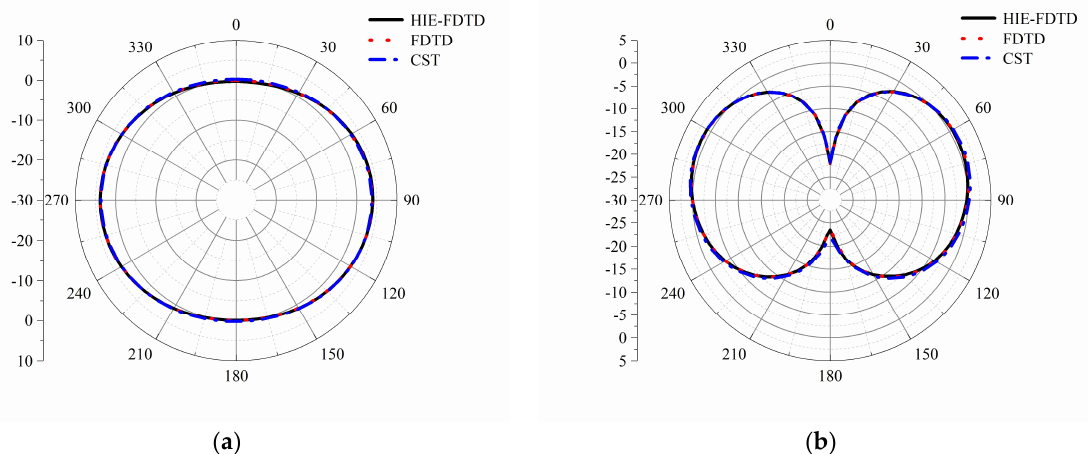
Figure 5. Directivity patterns of the planar monopole antenna: ( a ) directivity pattern in xoy plane; ( b ) directivity pattern in xoz plane.